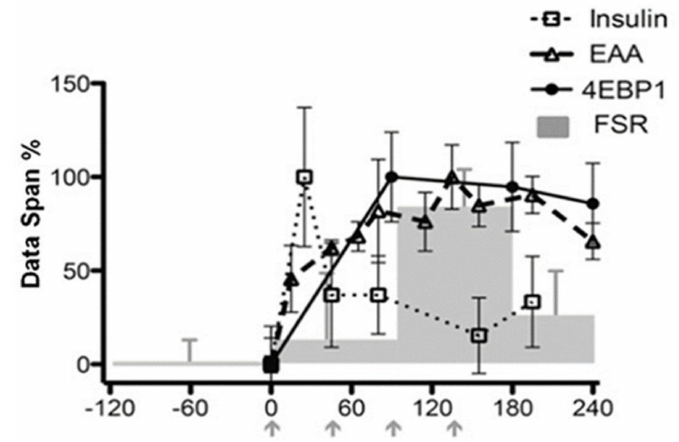
Figure 14. “Bag-full” effect in human skeletal muscle observed in the response of muscle protein synthesis to amino acid feeding [340]. Changes in muscle protein synthesis (FSR) measured in muscle biopsies at − 2, 0, 1.5, 3 and 4 h, plasma essential amino acids (EAA), insulin concentrations and phosphor-4EBP1Thr65/70 (eukaryotic translation initiation factor 4E-binding protein 1) from fasted to fed normalised to their own data spans shown on the same axis in young men after consumption of 4 meals of 3.75 g of essential amino acids every 45 min as indicated by the grey arrows. Values are means ± SEMs, n = 8. The FSR was increased between 90 and 180 min ( p < 0.05) but returned to baseline after this even though plasma EAA concentrations and muscle 4EBP1 phosphorylation remained elevated. Similar findings were reported by Atherton et al., 2010 [338] with an initial stimulation of the FSR 100 min after a single 48 g whey-protein bolus coinciding with an increase in intramuscular leucine which remained elevated at 200 min at which time the FSR had returned to baseline. Copied and adapted from Mitchell et al., 2015 [340] under the terms of the Creative Commons Attribution